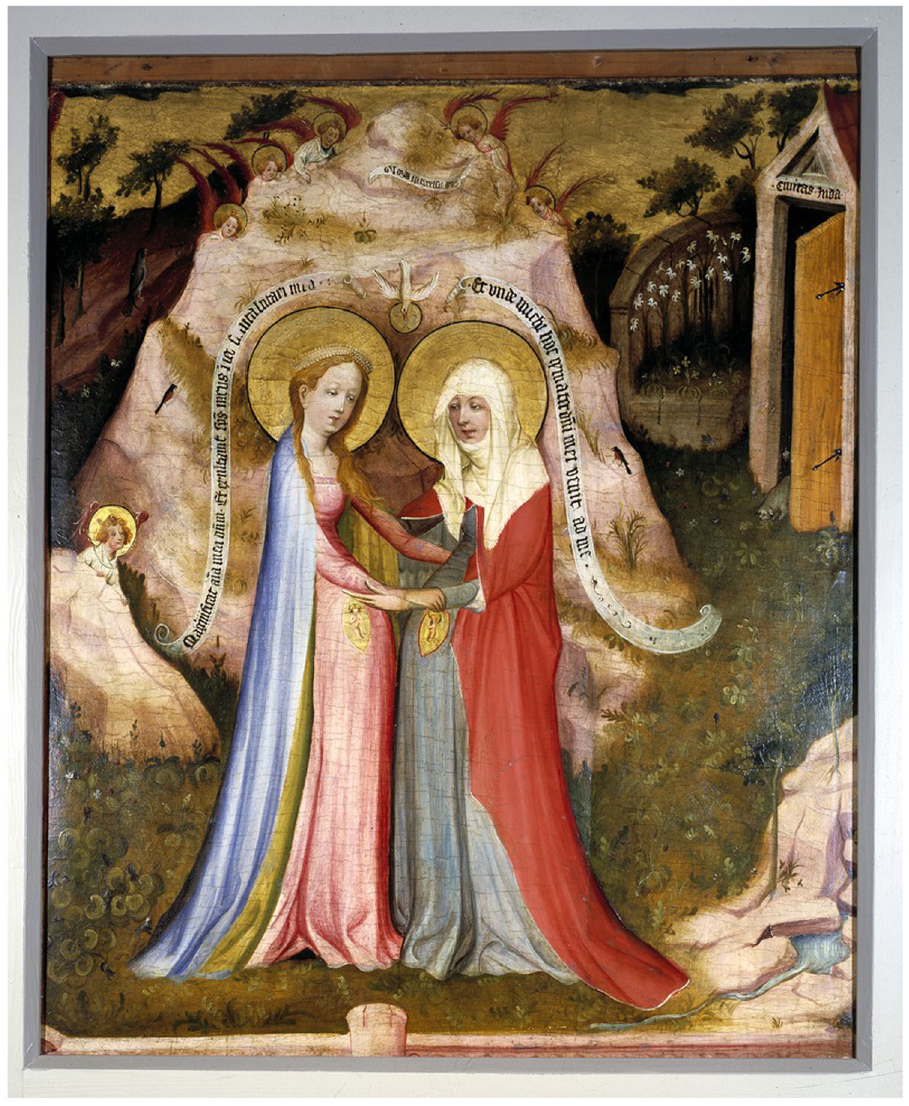
Image 3: Visitatie, Middelrijns Altaar, ca. 1410.